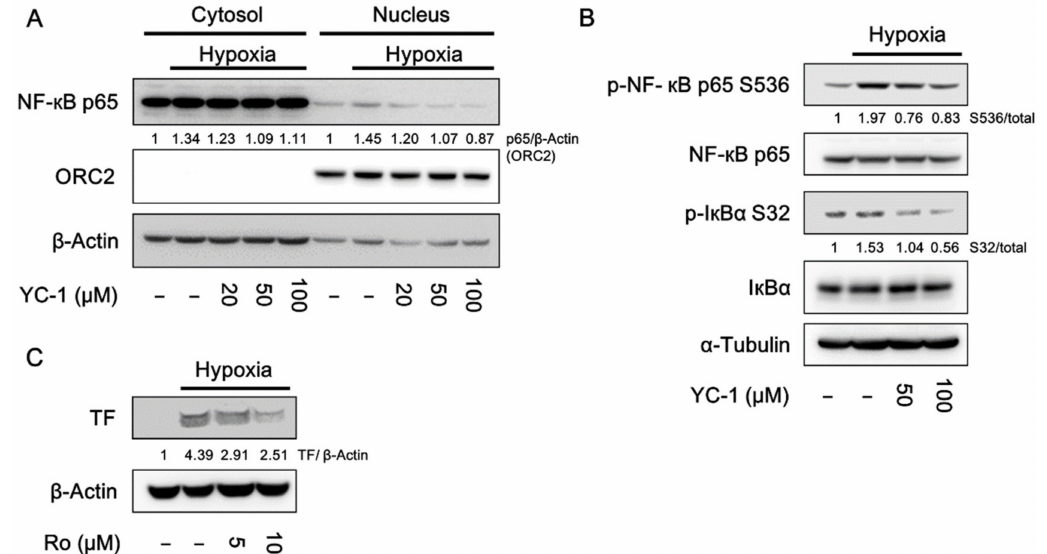
Figure 5. YC-1 inhibits hypoxia-induced NF- κ B activation in A549 cells. A549 cancer cells were pretreated with YC-1 for 1 h and exposed to normoxia or hypoxia. Protein levels of NF- κ B p65 in the cytosolic and nuclear fractions ( A ) and the phosphorylation of NF- κ B p65 and I κ B α in the whole-cell lysates ( B ) were determined by Western blotting. ( C ) A549 cells were pretreated with the NF- κ B inhibitor RO 106-9920 for 1 h and exposed to hypoxia for 24 h. TF expression was determined by Western